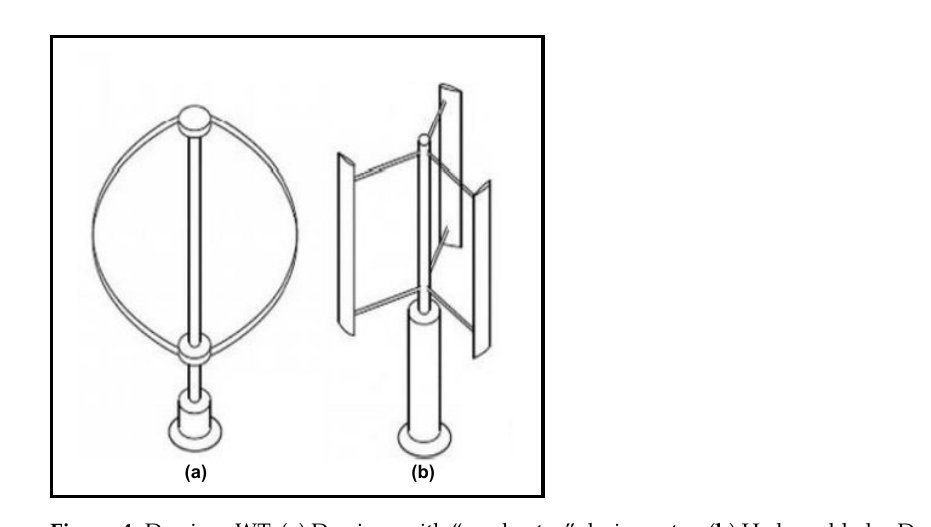
Figure 4. Darrieus WT: ( a ) Darrieus with “egg beater” design rotor, ( b ) H-shape blades Darrieus